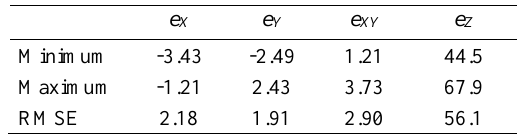
Table 1. Statistics of horizontal errors (X, Y and norm) of OM1 and vertical errors of DSM1, all in meters .